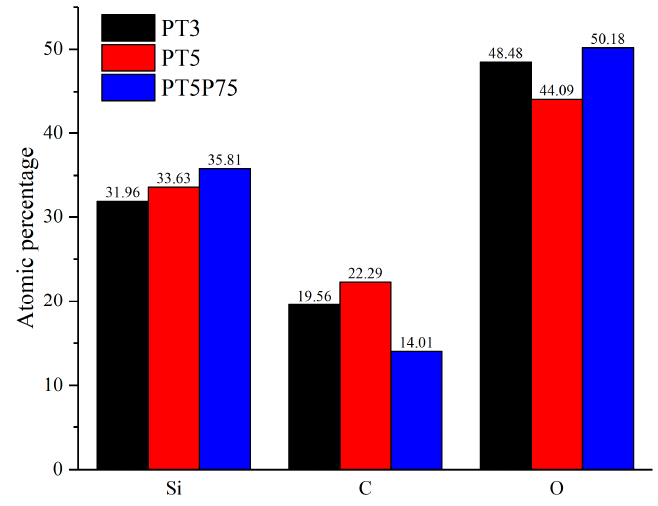
Figure 11. Atomic percentages of silicon, carbon and oxygen acquired from X-ray photoelectron spectrometer (XPS) for PT3, PT5, and PT5P75.